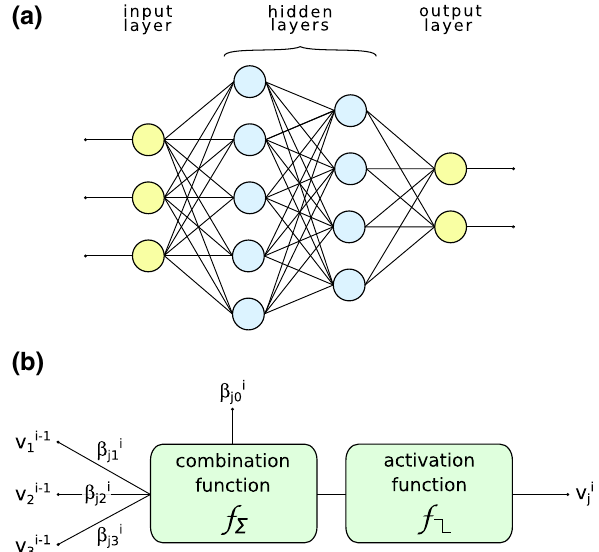
Fig. 1 a Example of a typical feed-forward neural network. The net- work processes three input variables to give two output values (3 → 2), with the architecture made out of two hidden layers. The first hidden layer contains five neurons, while the second one is made out of four neurons. b Schematic illustration of a typical neuron. In this example it is connected to three different neurons belonging to a previous layer of the network. For the explanation of symbols see the